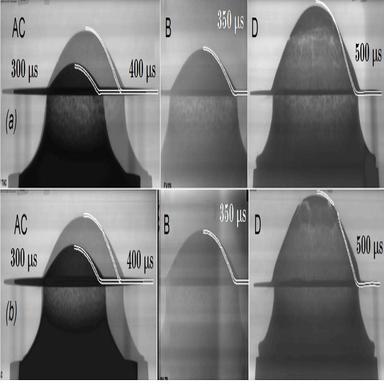
Experimental flash X-ray results and comparison with the calculations (shown as half plate white contours) for the moisturised coarse silica sand loaded by the configuration U charge, ρ0 = 1.55 g/cm3 (a) and configuration V charge, ρ0 = 1.41 g/cm3 (b).